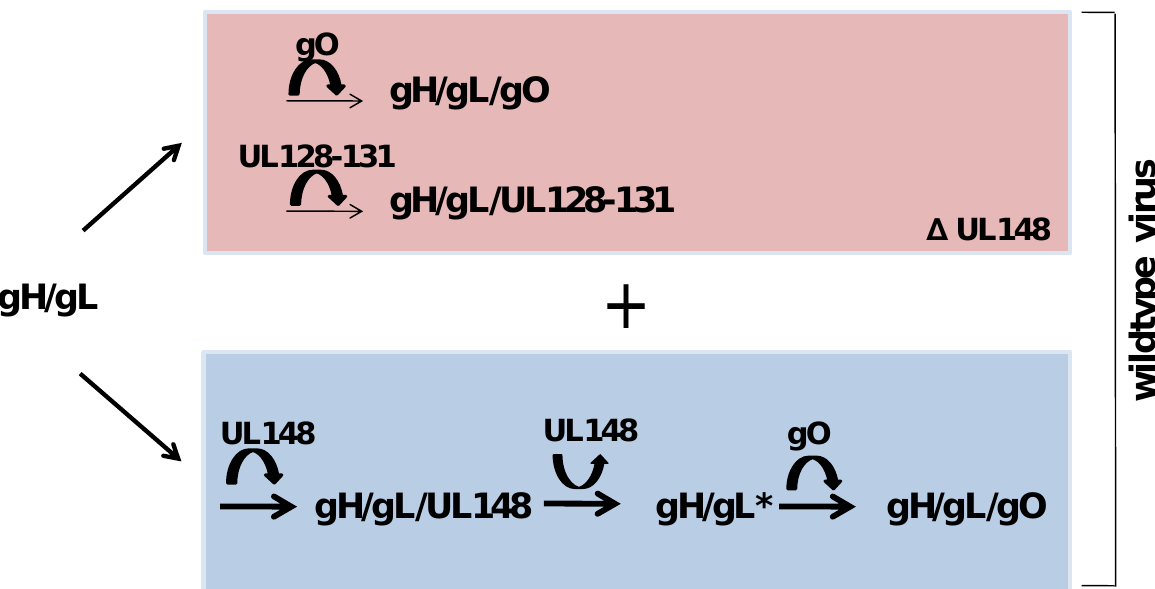
Figure 1. Model for a UL148-dependent regulation of alternative gH/gL complexes. HCMV strain-specific properties of the constituents of the gH/gL complexes determine the relative amounts of gH/gL/gO and gH/gL/UL128-131 complexes being formed and integrated into the viral envelope in the absence of UL148 (pink area). By reversibly binding to gH/gL, UL148 enhances binding of gH/gL to gO which results in an absolute increase in the amount of gH/gL/gO complexes in virions (blue area).